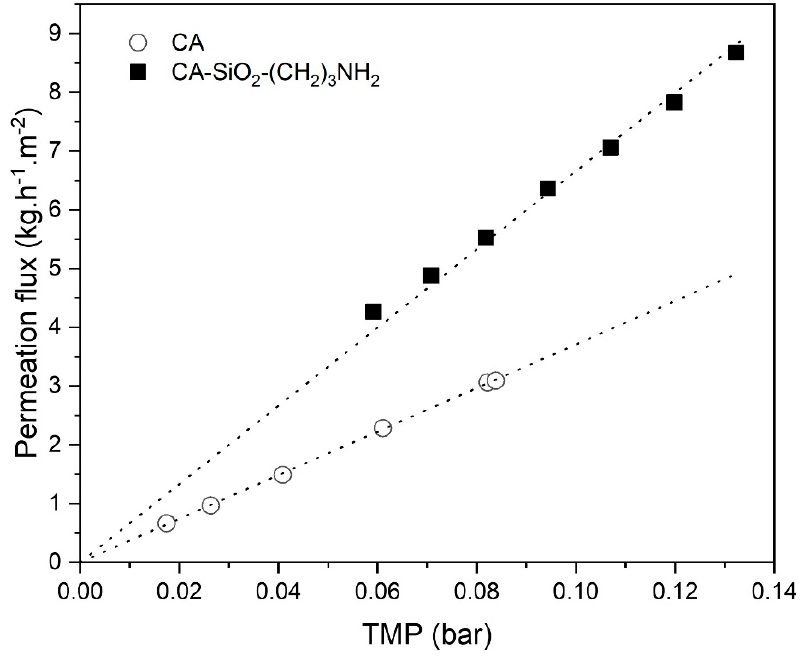
Figure 7. Ultrafiltration flux of pure water at 37 °C as a function of the transmembrane pressure for CA-SiO 2 -(CH 2 ) 3 NH 2 ( ■ ) and pure CA ( ○ ) membranes. The dotted lines represent the linear fit, which enables the determination of each membrane Lp.